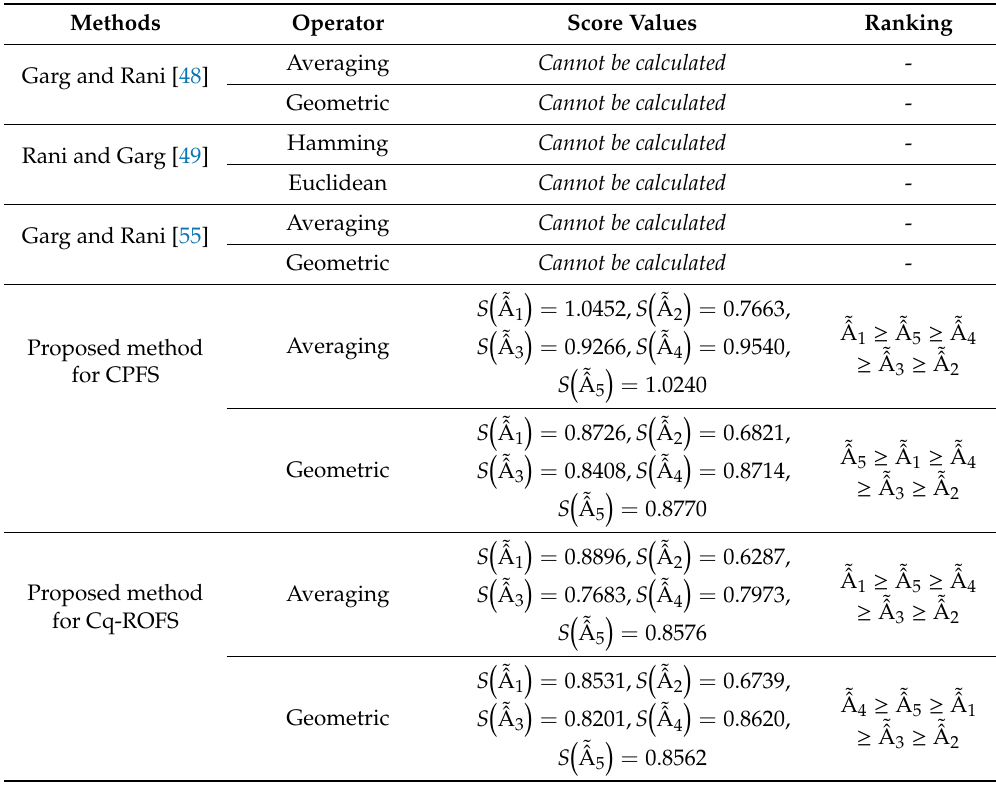
Table 10. Comparative analysis for Example 6.